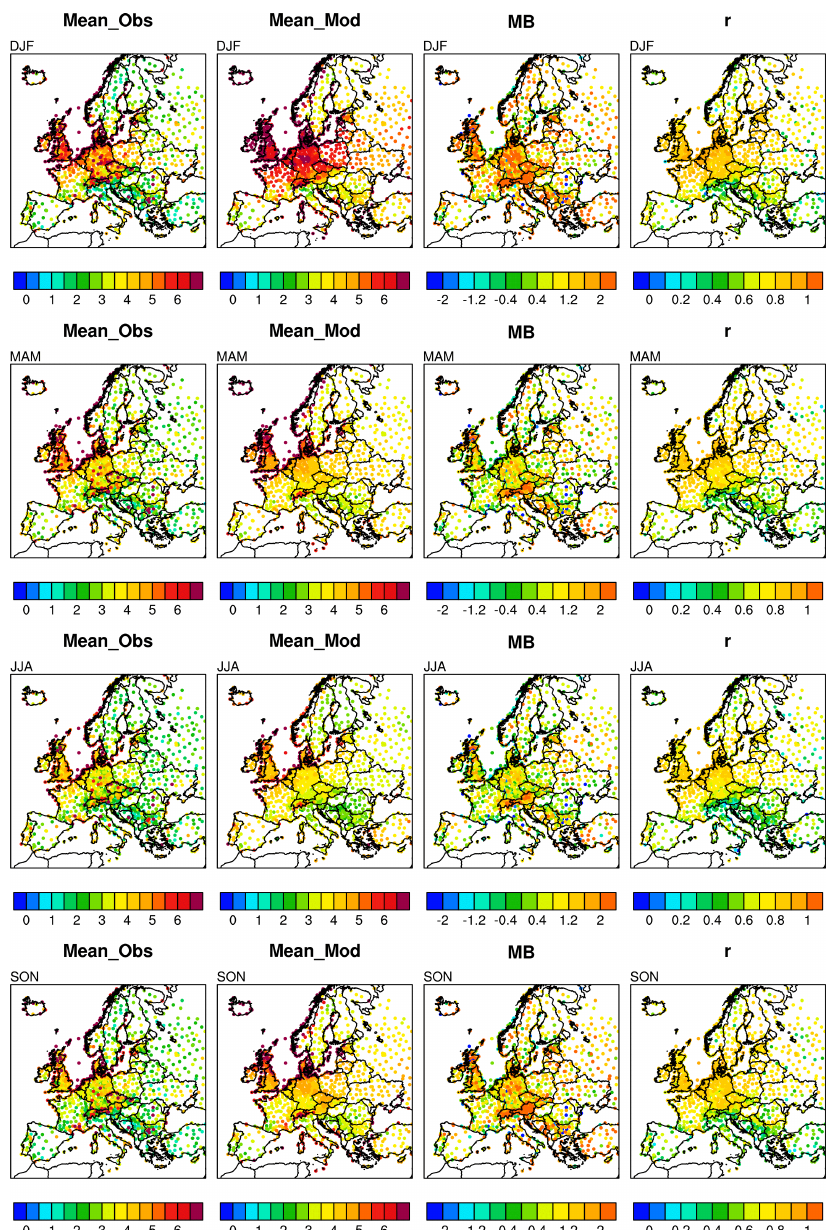
Figure 2. Seasonal average values of 10m wind speed (WS10) in ms − 1 . Model results and statistics are shown for the MOZART simulation at the locations of the